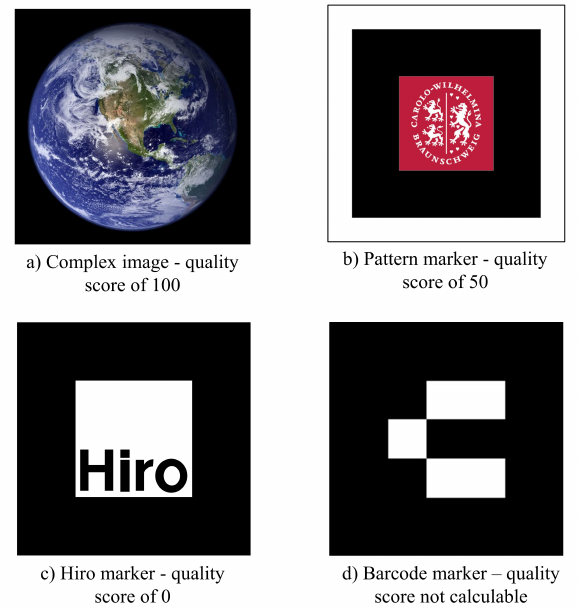
Figure 1. ARCore quality score for selected reference